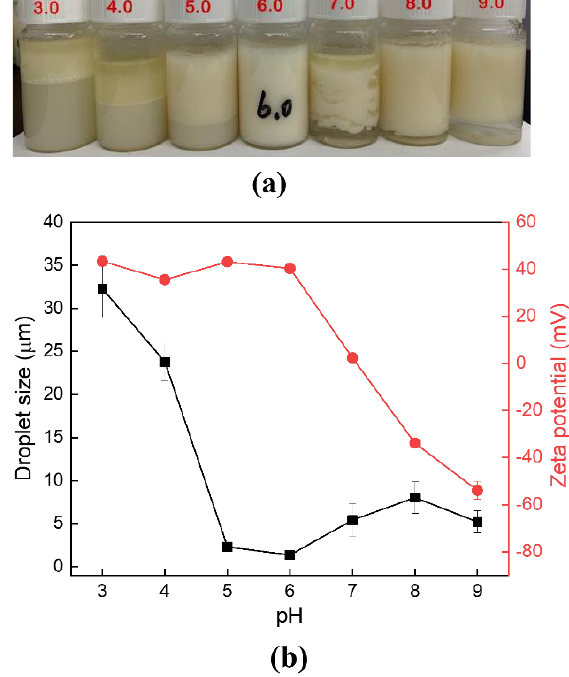
Figure 11. Effects of pH value on appearance ( a ) and droplet size ( b ) of Pickering emulsions stabilized by CS-PA-CD nanoparticles.